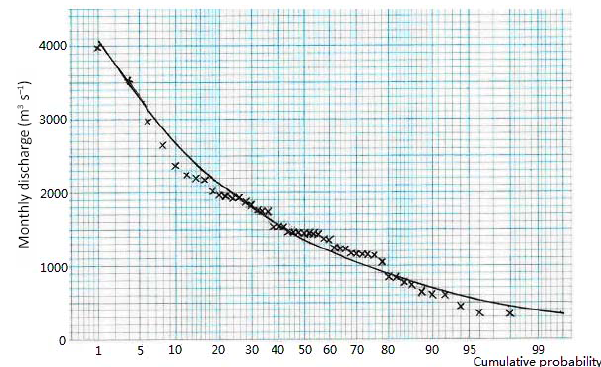
Figure 4. Predicted distribution of the discharge on 30 June at the Haerbin station using a conditional Log normal probability distri- bution.